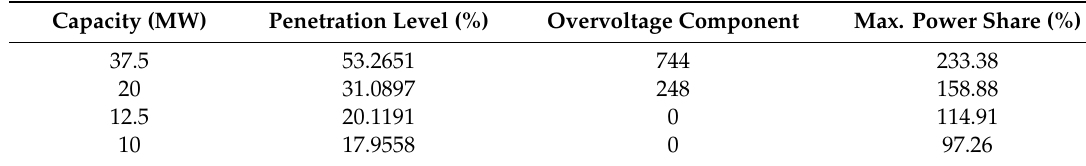
Table 6. Number of Overvoltage Cases during July 2017